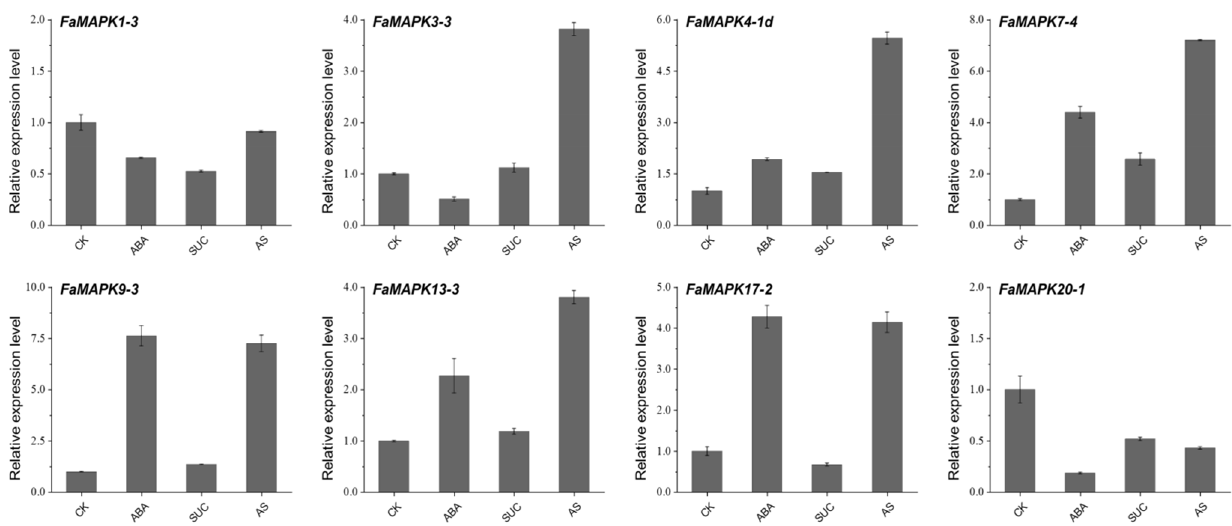
Figure 10. Expression profiles of FaMAPK genes at exogenous ABA and sucrose treatments.